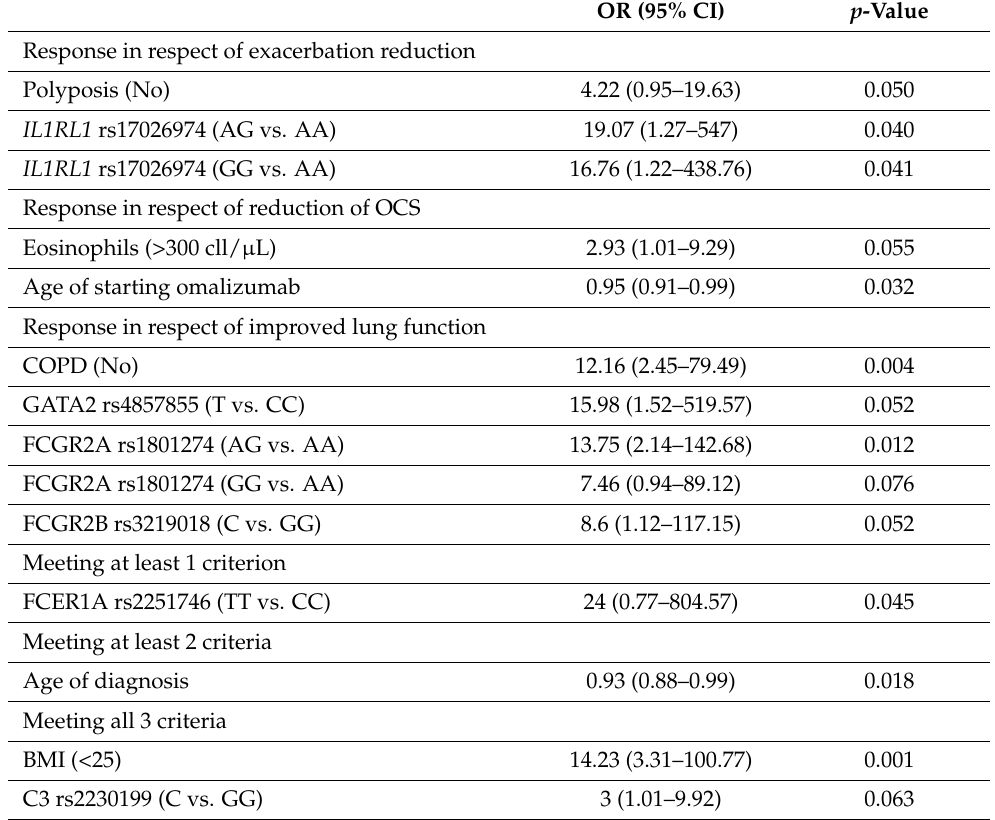
Table 3. Predictors of response after 12 months of omalizumab treatment in patients with severe uncontrolled asthma (multivariate